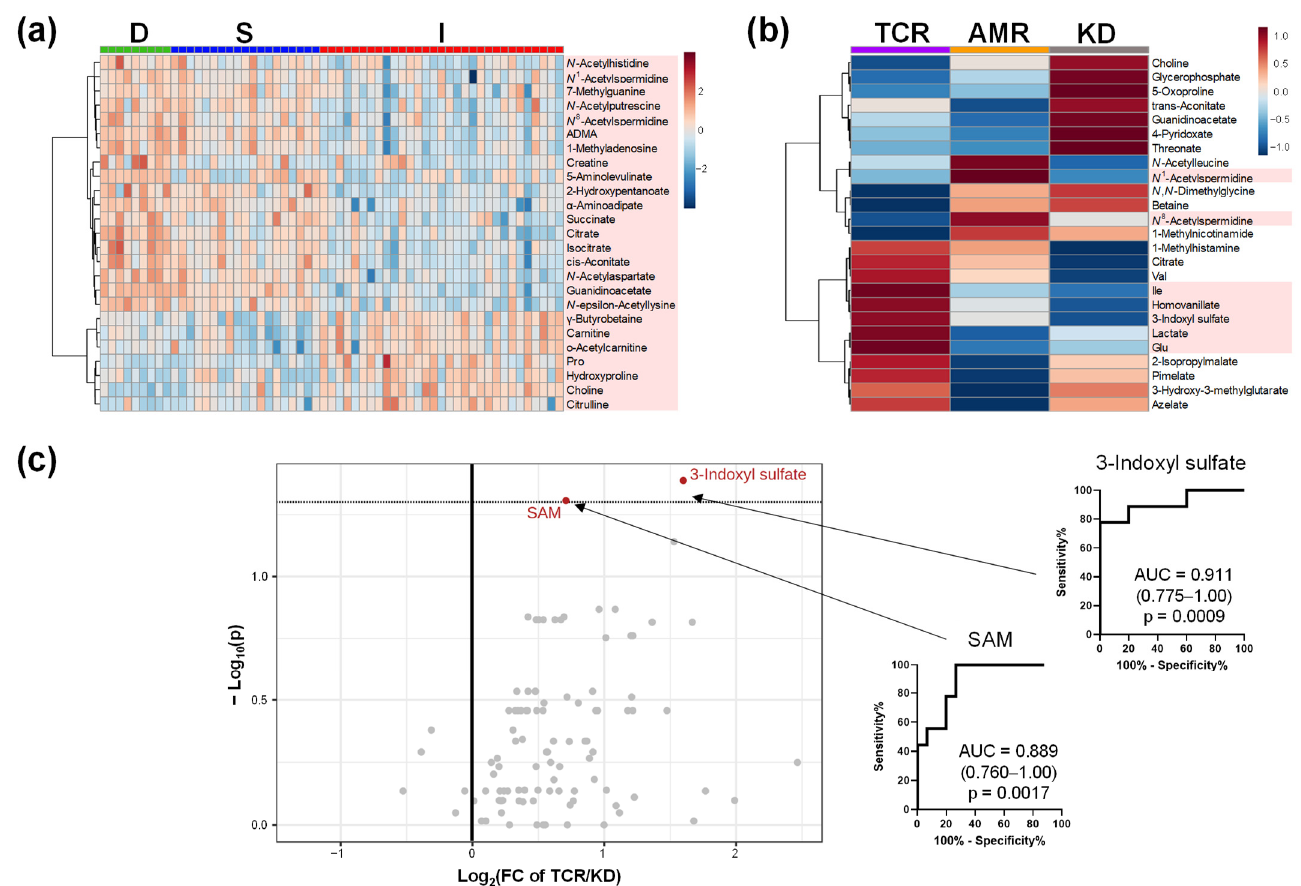
Figure 4. The urinary metabolomic profile. ( a ) Heatmap of groups D, S, and I; ( b ) Heatmap of groups TCR, AMR, and KD; ( c ) Volcano plots between TCR and KD. The processing is the same as the legends in Figures 1a, 2b and 3a. D, Donor group; S, kidney transplant recipients with stable kidney function; I, kidney transplant recipients with impaired kidney function; TCR, T cell-mediated rejection group; AMR, antibody-mediated rejection group; KD, kidney dysfunction other than rejection group.